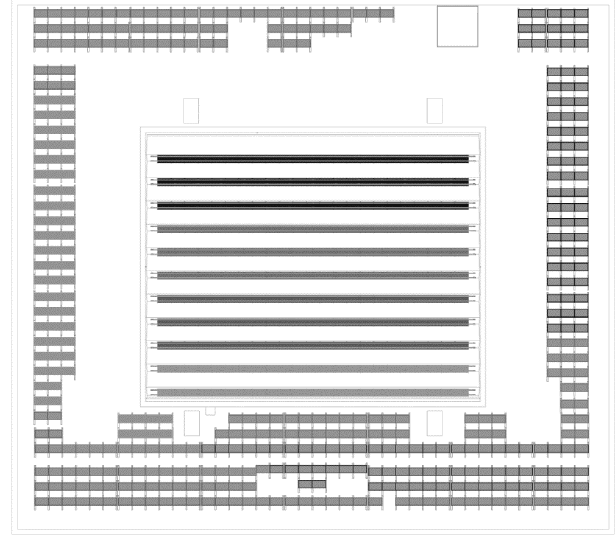
Figure 4. Arrangement of photovoltaic panels on the roof.